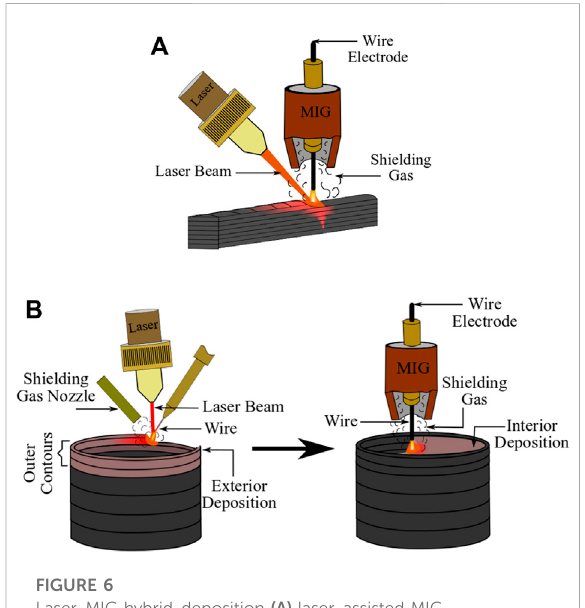
FIGURE 6 Laser-MIG hybrid-deposition (A) laser-assisted MIG deposition and (B) feature-based laser and MIG deposition.